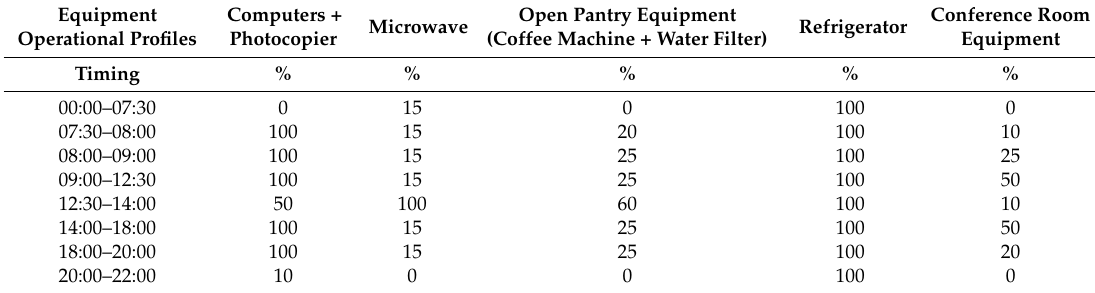
Table 3. Equipment operational